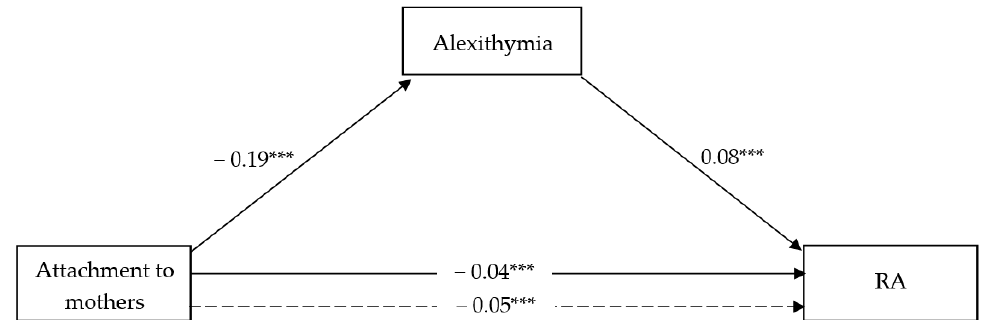
Figure 1. Attachment to mothers and RA. *** p < 0.000; dotted line = Total effect.